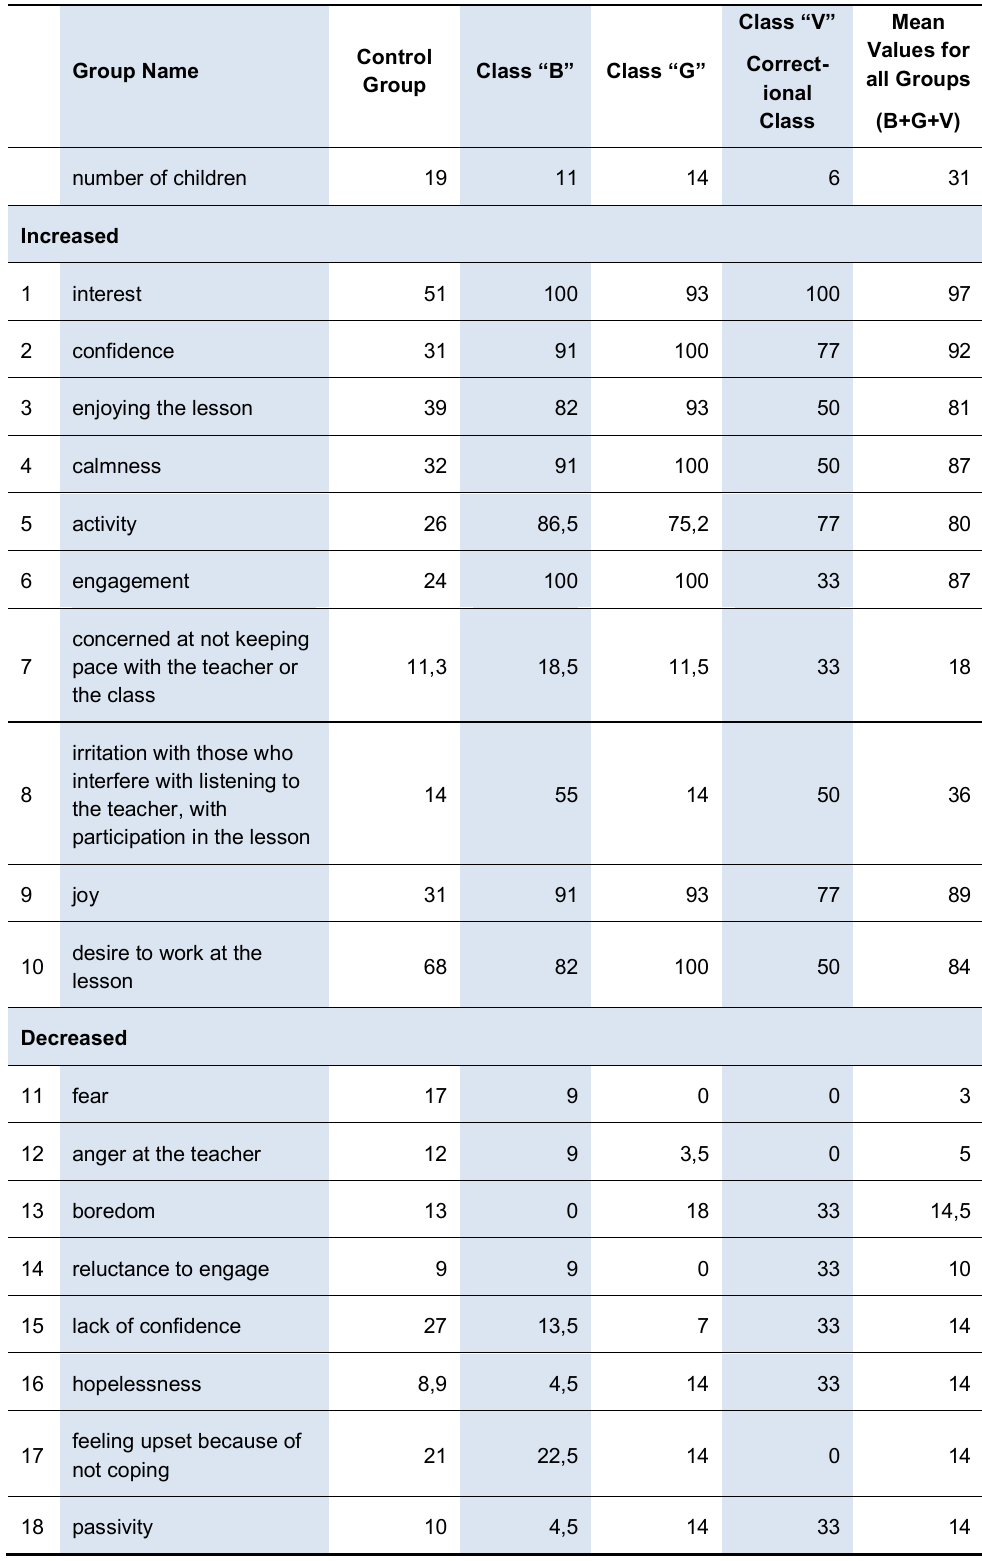
Table 3: Data for the sub-groups of the assistant